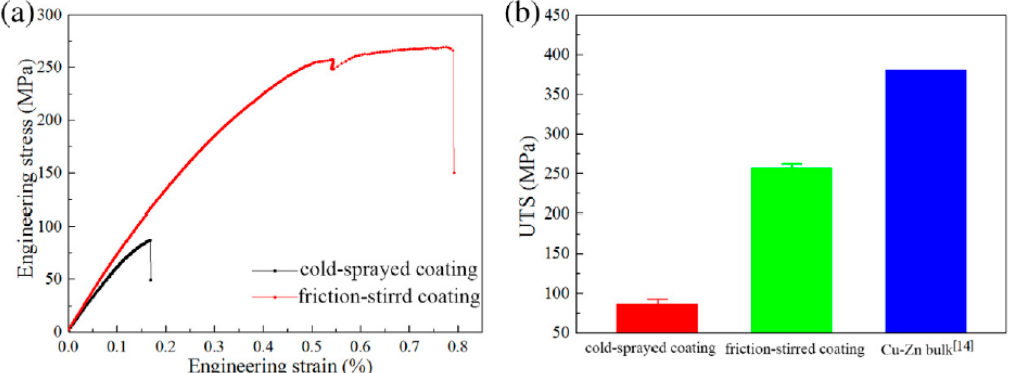
Figure 12. ( a ) Typical stress–strain curves and ( b ) ultimate tensile strength of as-sprayed and friction-stirred coatings (adapted from reference [59] , with permission from © Elsevier).